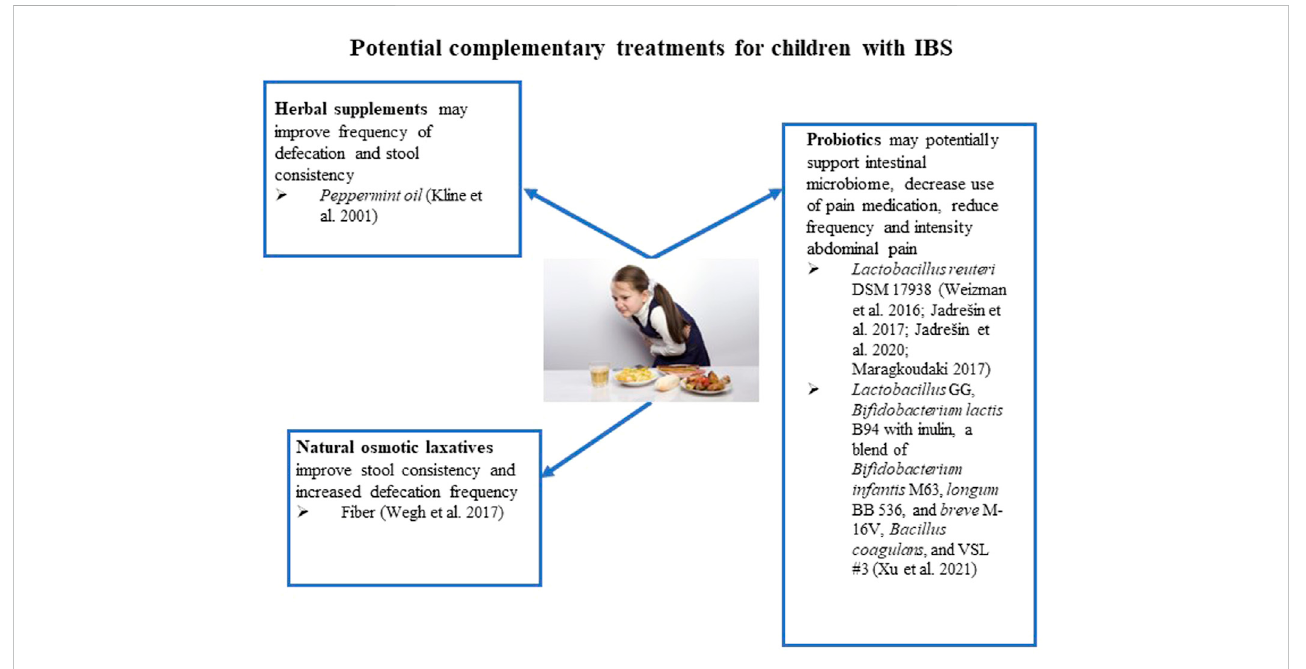
FIGURE 3 Potential complementary treatments for children with